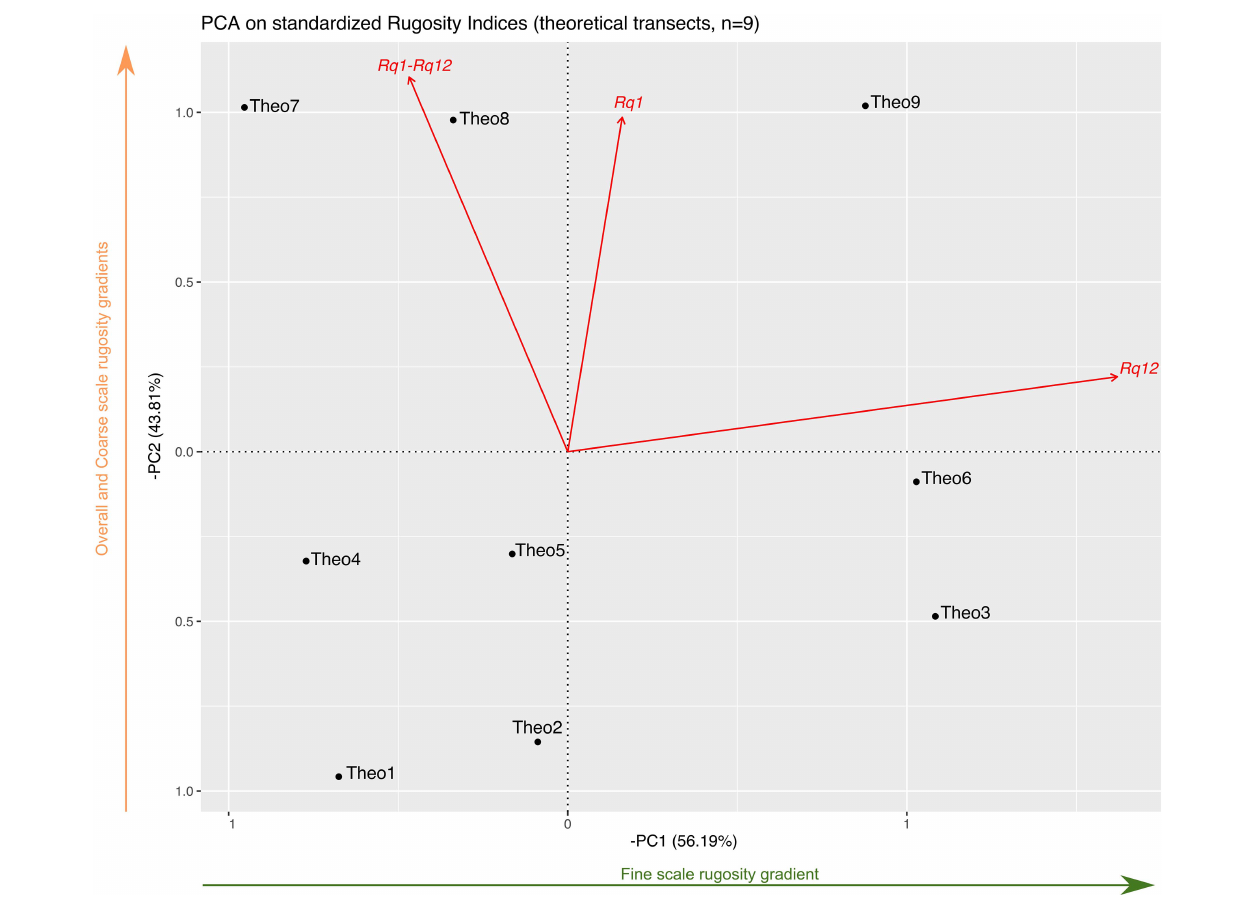
FIGURE 6 | PCA representation of rugosity indices for the nine theoretical transects. PCA axes are displayed as their inverse to better visualize rugosity gradients; this did not influence the relative position between transects. Scores reported in the text are the exact scores obtained by the PCA analysis without inversion of the x - and y -axes. Red arrows represent the variables’ vectors, the green arrow under the x -axis illustrates the fine scale rugosity gradient between transects, and the orange arrow beside the y -axis represents the overall and coarse scale rugosity